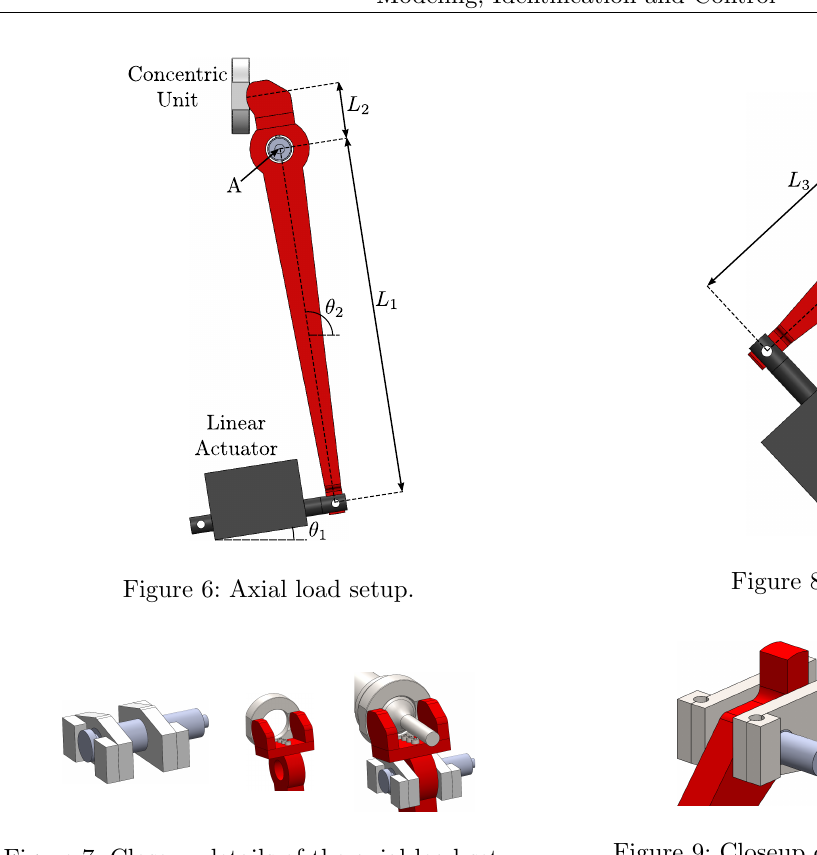
Figure 7: Closeup details of the axial load setup.